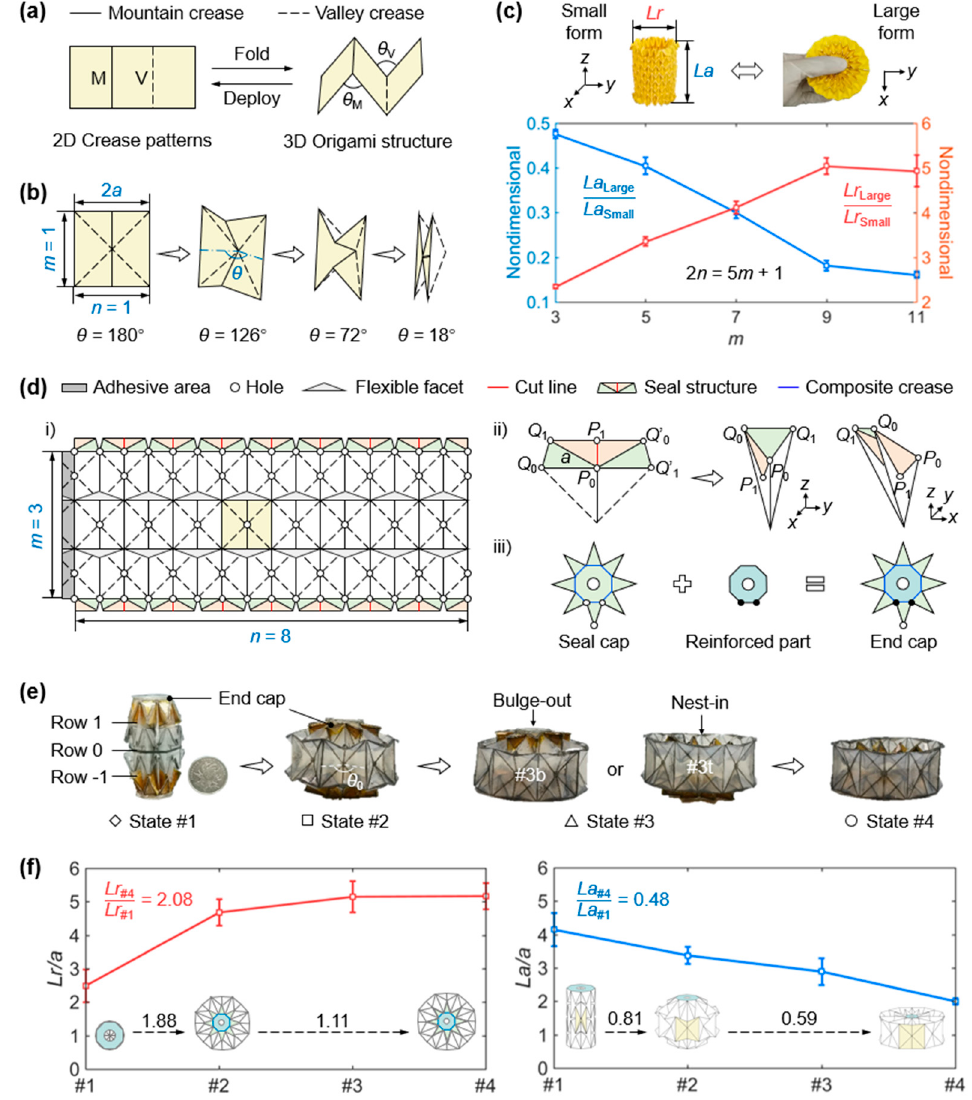
Figure 2. Origami design and analysis. ( a ) Origami mechanism. ( b ) The folding sequence of the Waterbomb base. ( c ) Five groups of Waterbomb satisfy the equation 2 n = 5 m + 1. ( d ) Waterbomb ( m = 3, n = 8). (i) CPs; (ii) seal structure; (iii) End cap. ( e ) Deploying sequence of the Waterbomb. Materials: backbone (PET + PTFE), end cap (PET + PI). ( f ) Standard ratios of radial and axial